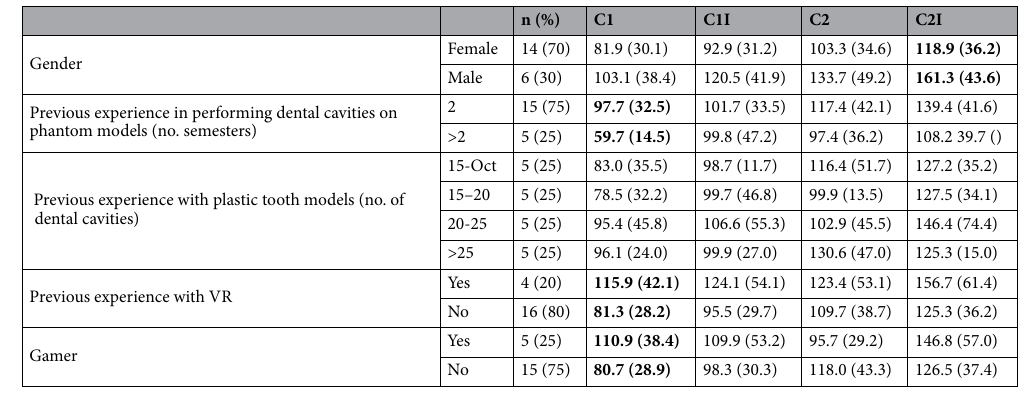
Table 2. Drill time (s) (presented as mean standard deviation), at experiment session S3, for the considered tasks vs. participants characteristics/previous experience. *Comparisons by Student’s t-test and ANOVA (for previous experience with plastic tooth models). Significantly different means (p < 0.05) are denoted in